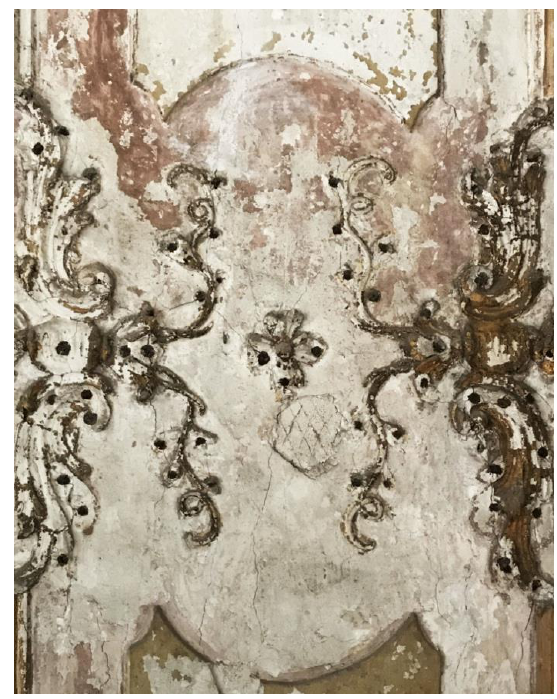
Figure 12. Wall 4: detail of the keying layer and of the iron nails used for on-site made